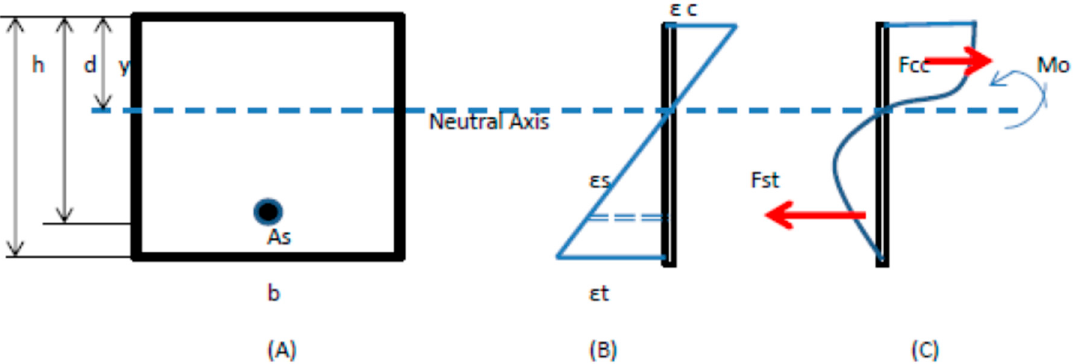
Figure 9. Neutral axis across ( A ) cross section of the beam; ( B ) strain diagram; ( C ) stress diagram. NA: neutral axis.